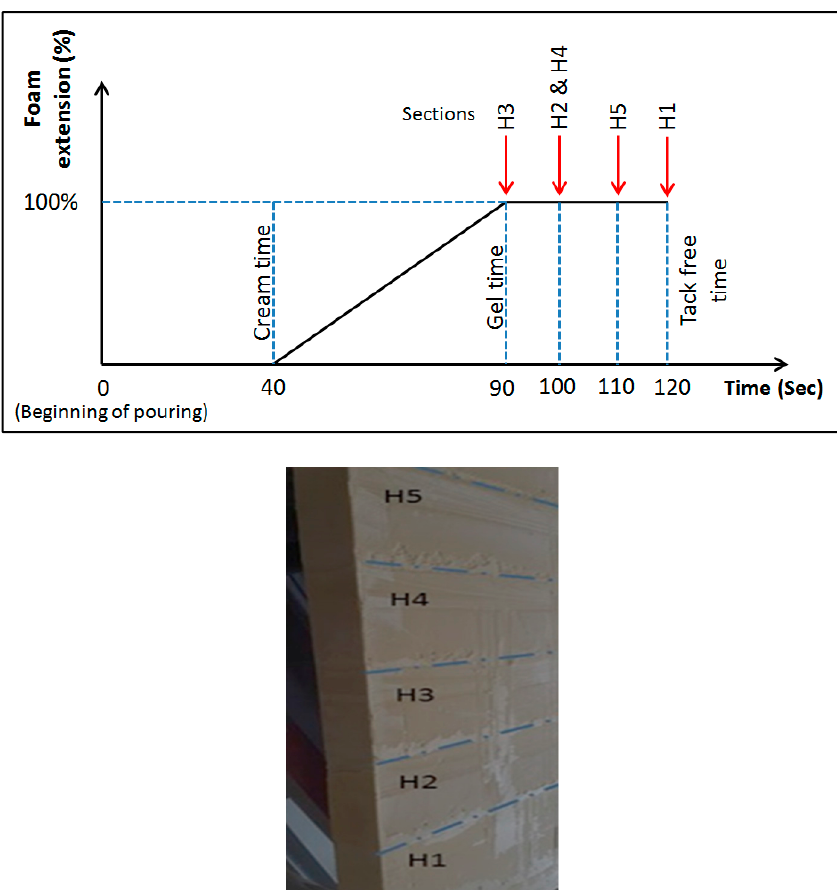
Figure 9. Casting schedule of seams at specimens with transverse seams (TS). Locations of transverse